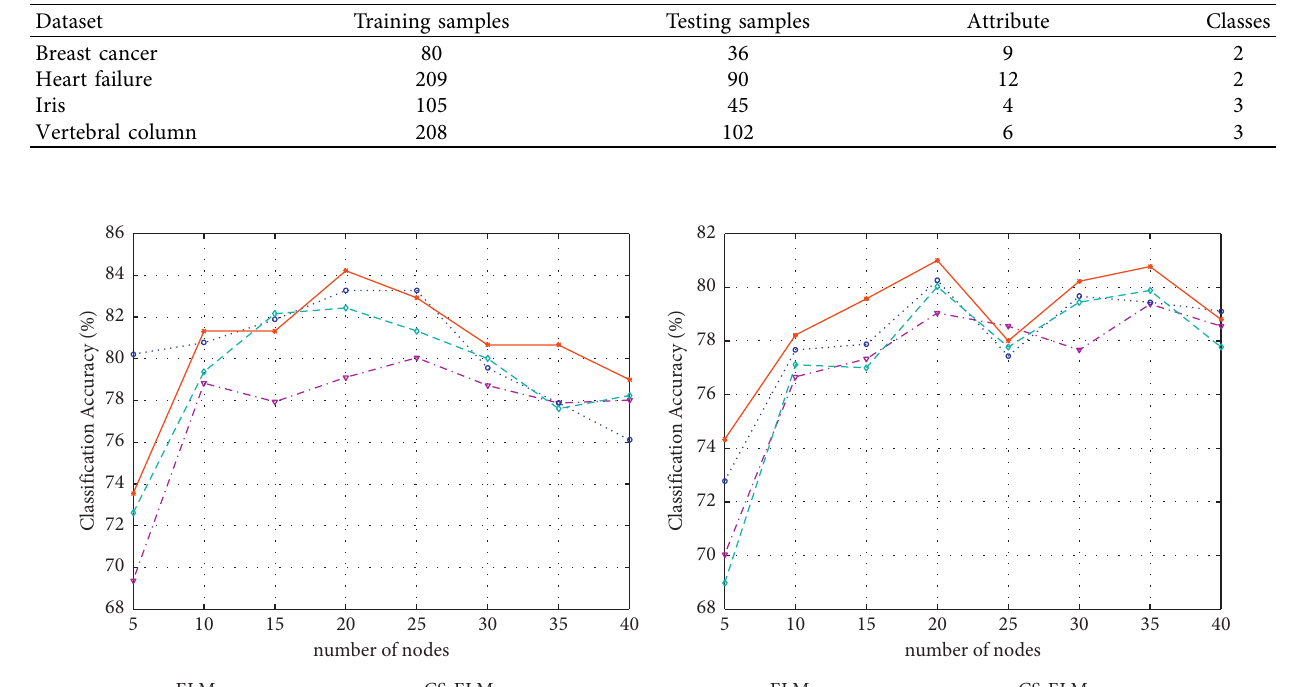
Table 6: The detailed description of the classification dataset.